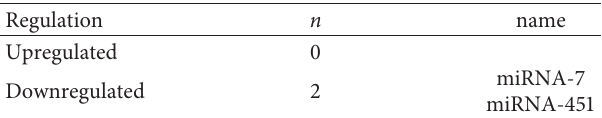
Table 2: Differentially expressed miRNA between the normal people and patients with